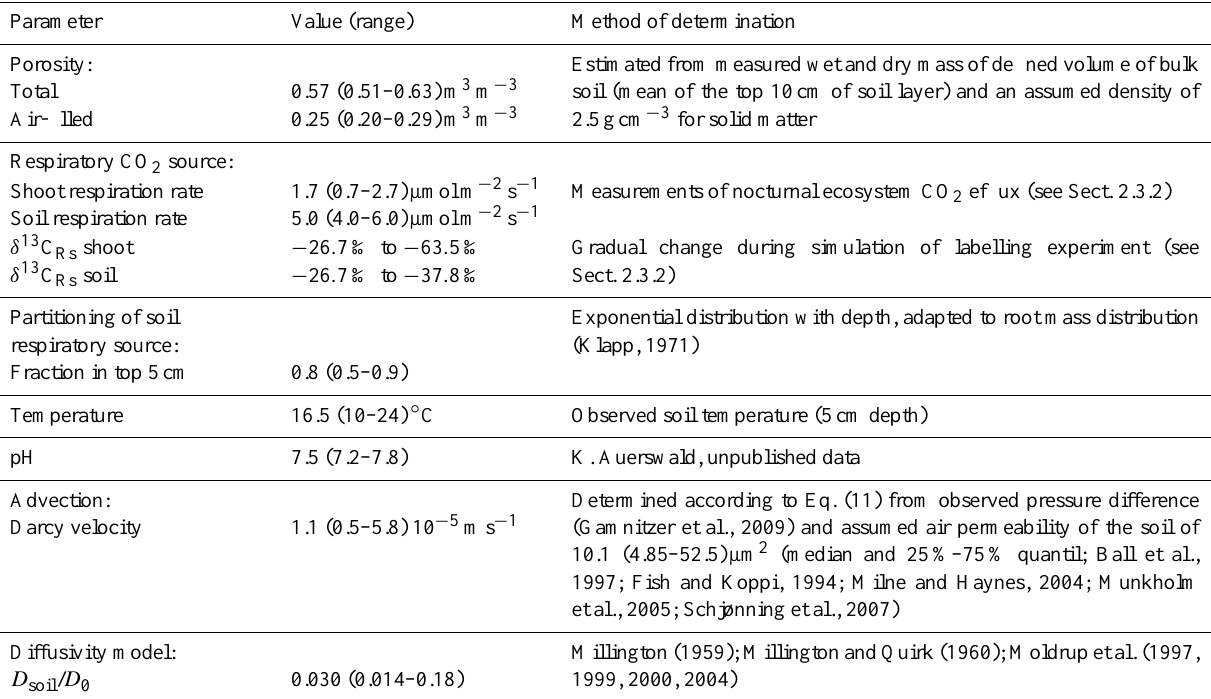
Table 1. Parameters characterizing conditions for CO 2 transport in the soil at the Gr¨unschwaige field site. Parameter Method of